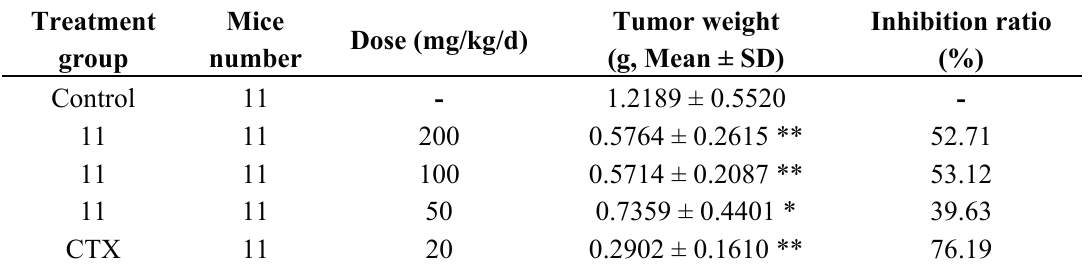
-bearing mice. 22